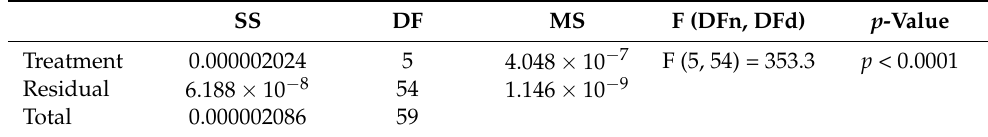
Table 10. ANOVA test applied to the prediction results achieved by the proposed optimized ensemble model applied to the wind speed